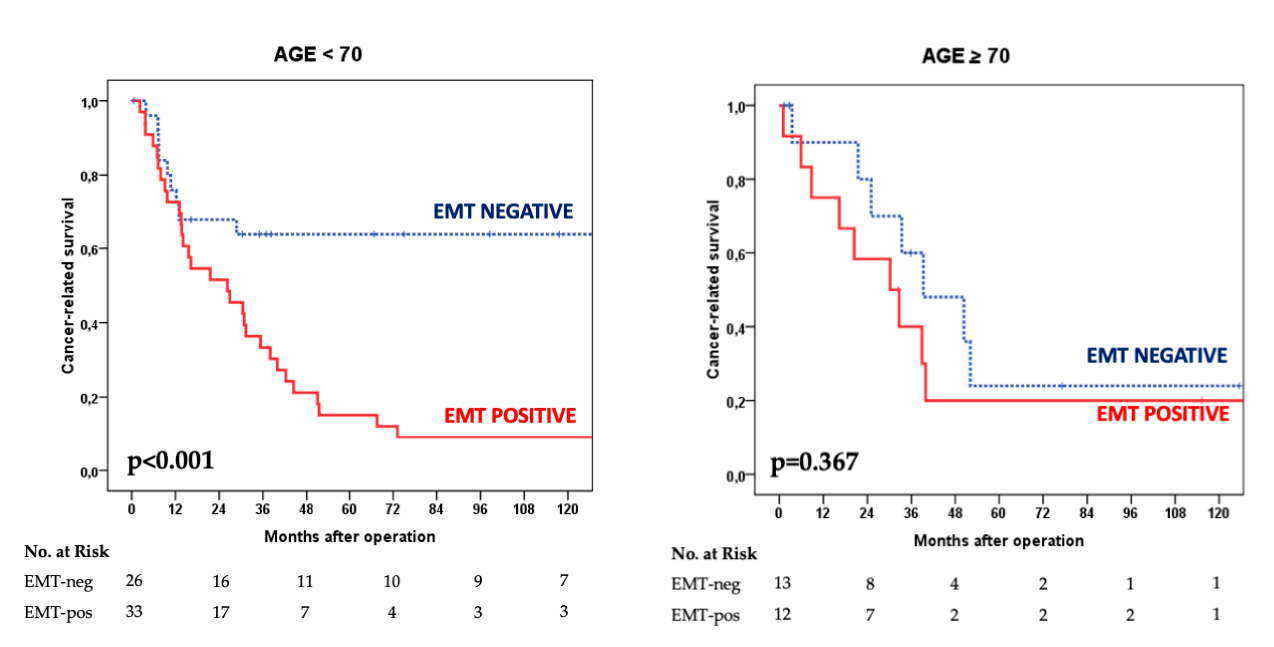
Figure 5. Cancer-specific survival according to EMT status: ( a ) MSS diffuse-type tumors that did not involve the serosa and ( b ) MSS diffuse-type tumors that involved the serosa; stratified for age groups: ( c ) <70 years old and ( d ) >70 years old (Log-rank test).